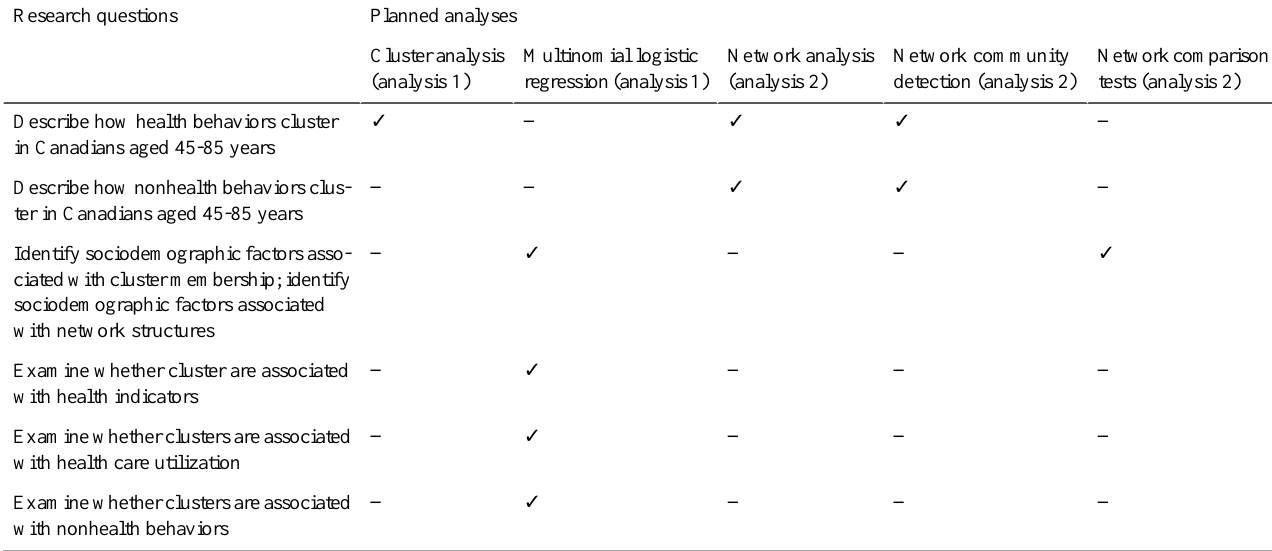
Table 1. Overview of research questions and planned